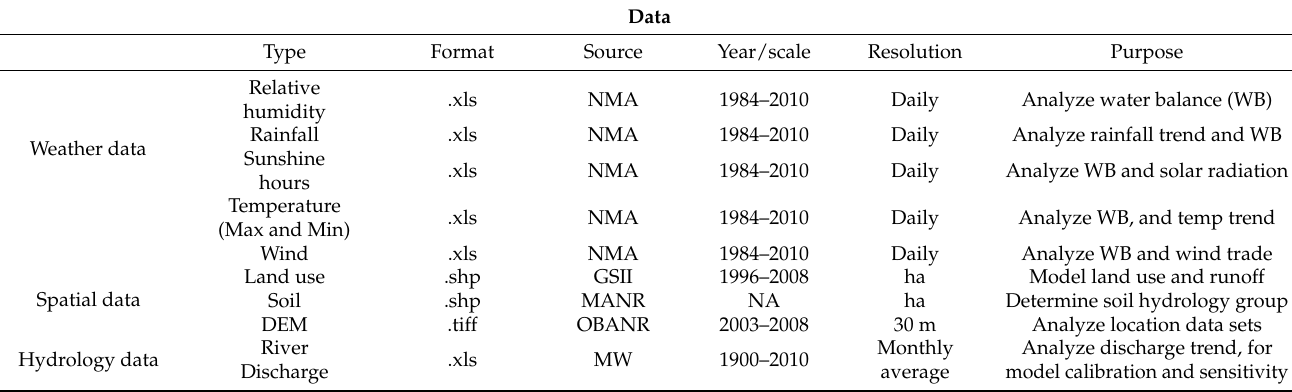
Table 1. Major input data used in the SWAT